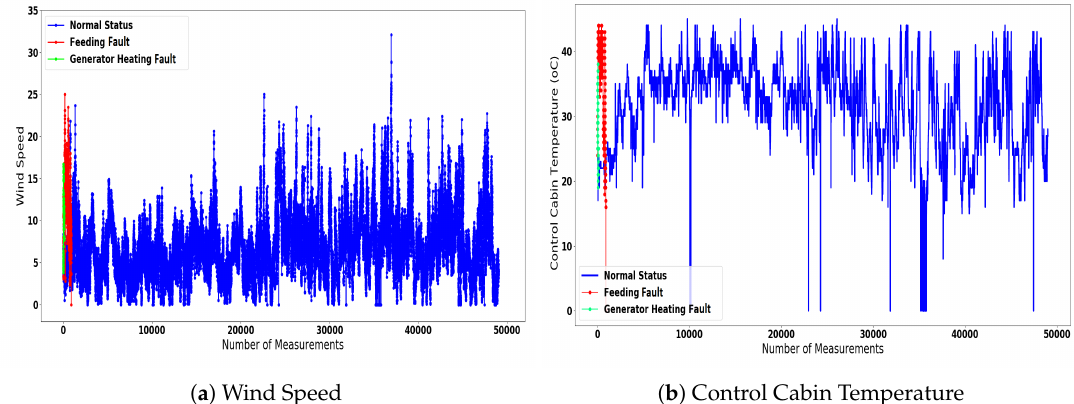
Figure 3. In this figure two characteristic measurements are illustrated: the Wind Speed and the Control Cabin Temperature, under the normal operating state and under the two faulty states: the feeding fault and the generator heating